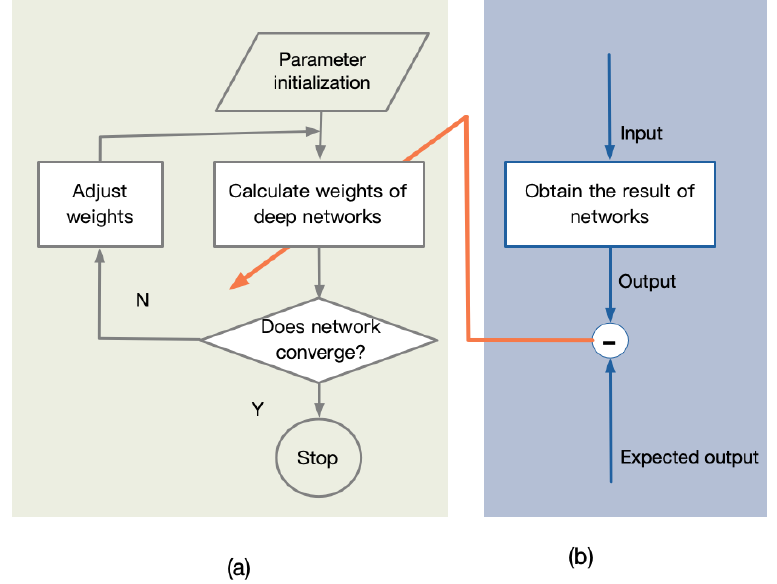
Figure 5. Hyperparameter optimization process. ( a ) The training process; ( b ) The weights’ optimiza- tion